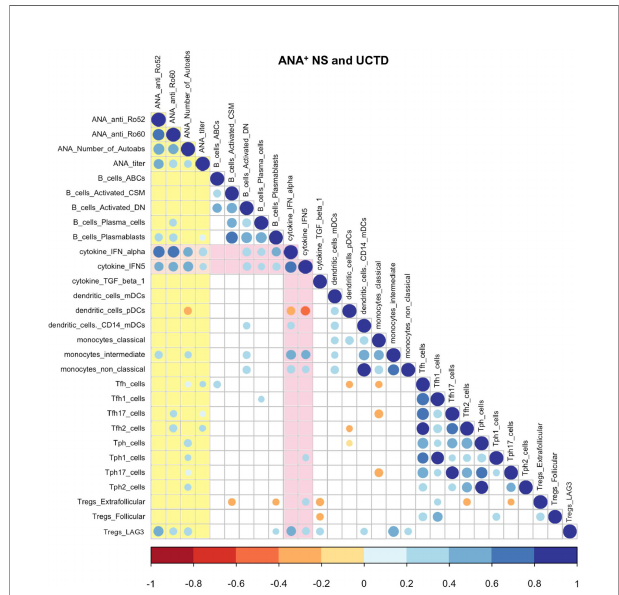
FIGURE 4 | Spearman correlation matrix between cellular and selected serologic/cytokine phenotypes in anti-nuclear antibody positive (ANA + ) individuals lacking a systemic autoimmune rheumatic diseases (SARD) diagnosis. The color and size of the dots represents the r value, with the scales shown at the bottom of each matrix. Non-signi fi cant (p ≥ 0.05) correlations are not displayed. Associations with autoAb levels are highlighted in yellow and those with IFN levels are highlighted in pink. ANA, anti-nuclear autoantibody; CSM, class-switched memory; DN, double-negative; IFN, interferon; TGF, transforming growth factor; mDCs, myeloid dendritic cells; pDCs, plasmacytoid dendritic cells; Tfh, T follicular helper; Tph, T peripheral helper; Tregs, T regulatory